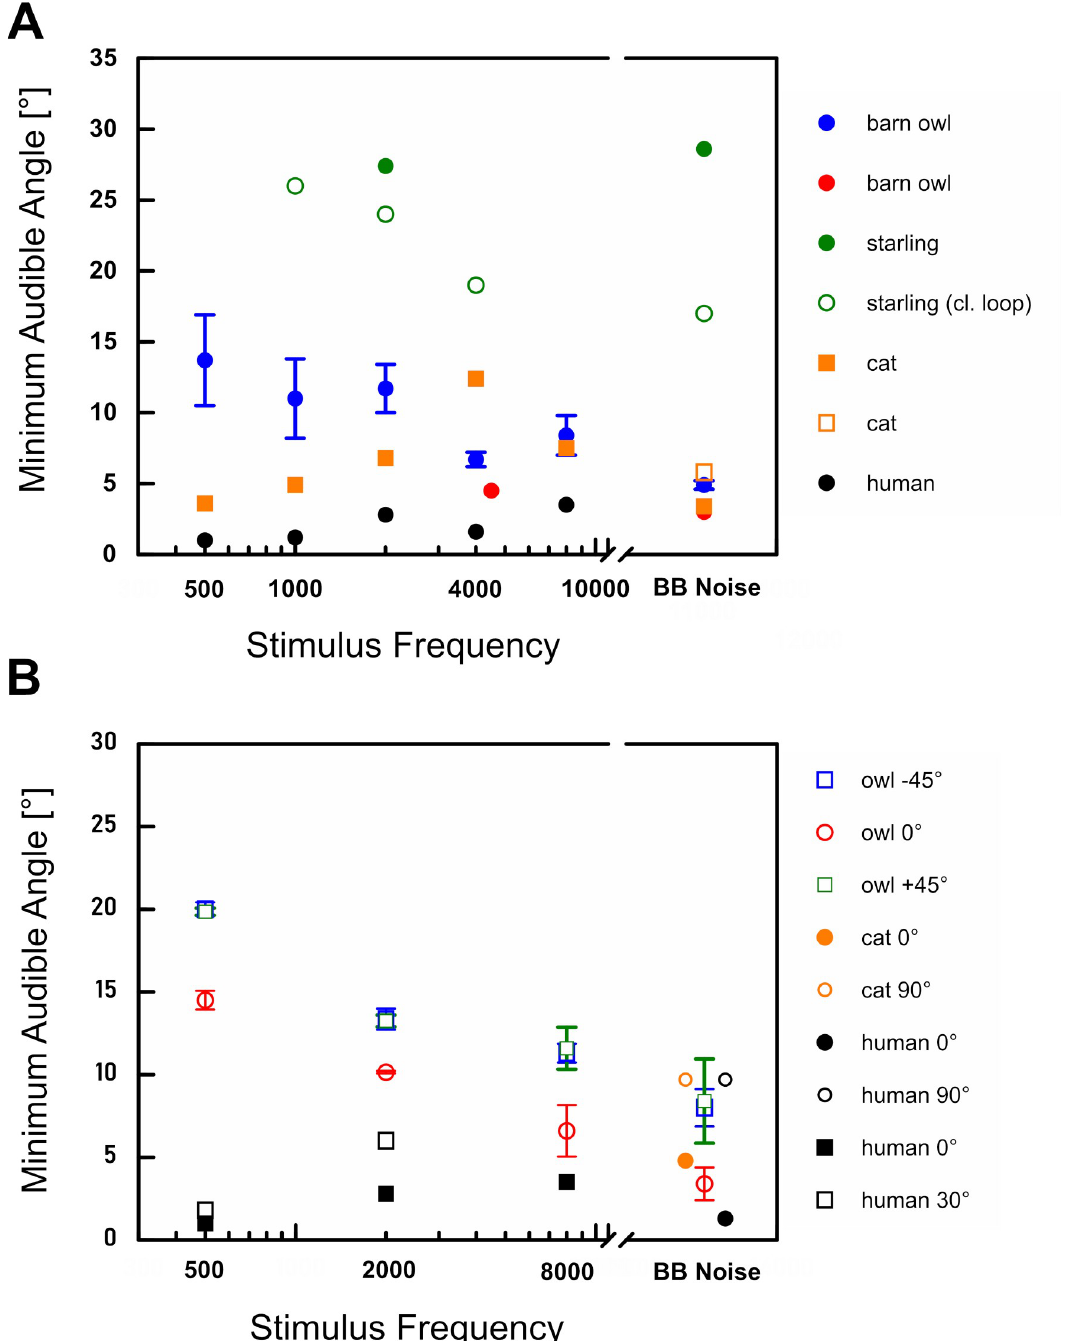
Fig 3. Minimum Audible Angle (MAA) as a function of stimulus type in different species. Data from different sources: (A) owl (blue dot, present study, N = 3), owl (red dot, Bala and Takahashi 2000, N = 5), starling (green dot, green circle, Feinkohl and Klump 2013, N = 4), cat (orange squares, Martin and Webster 1987, N = 5), human (black dot, Mills 1958, N = 3); (B) owl (blue square, red circle, green square, present study, N = 2), cat (orange dot, orange circle, Heffner and Heffner 1988, N = 4), human (black dot, black circle, Heffner and Heffner 1988, N = 4), human (black squares, Mills 1958, N = 3). The reference position in (A) was at 0˚ in azimuth and in (B) different reference positions were used.